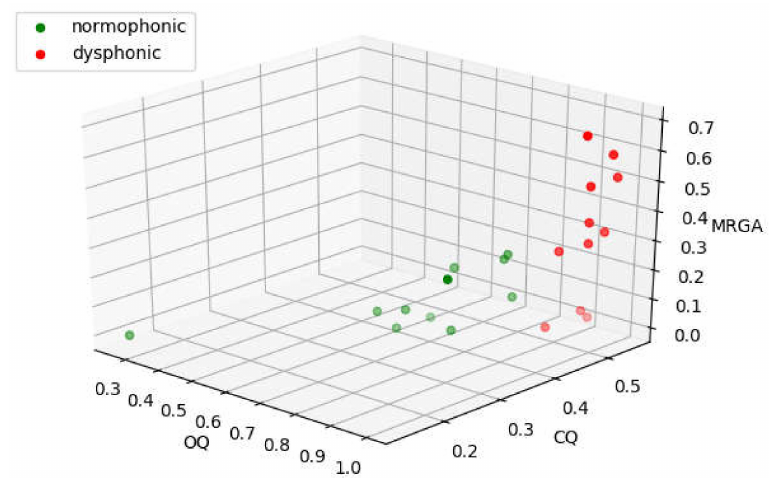
Figure 14. 3D plot for indices MRGA, OQ, CQ illustrating good discrimination of the normophonic subjects (green dots) and patients with glottal insufficiency (red